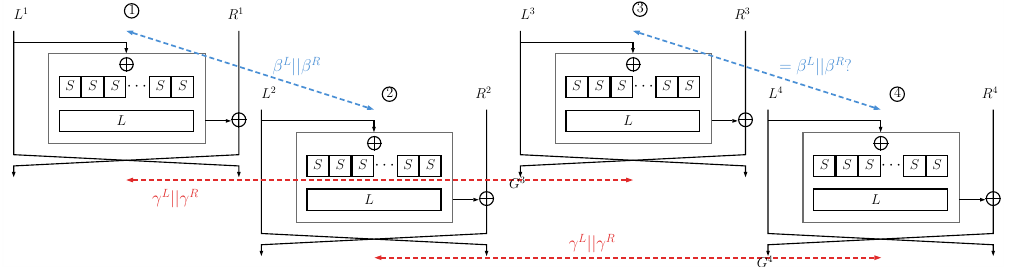
Figure 5: Boomerang switch over a generic Feistel